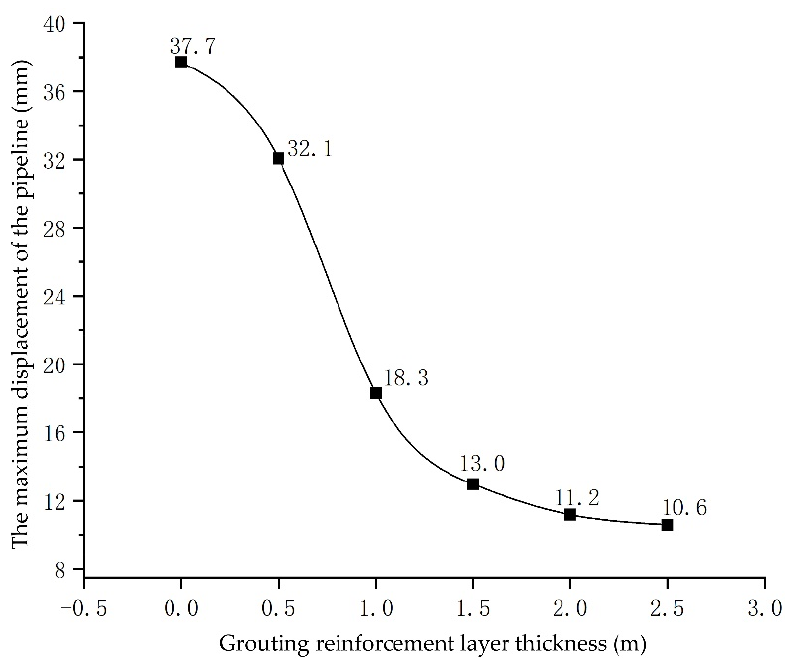
Figure 18. Relationship between the maximum displacement of the pipeline and grouting reinforcement layer thickness.